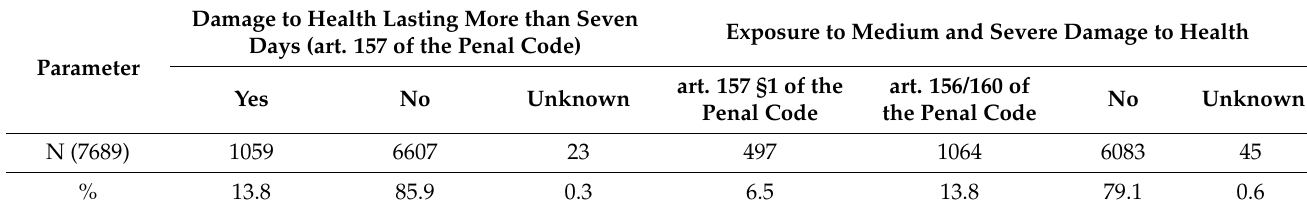
Table 2. Categorization of incidents by victim exposure.